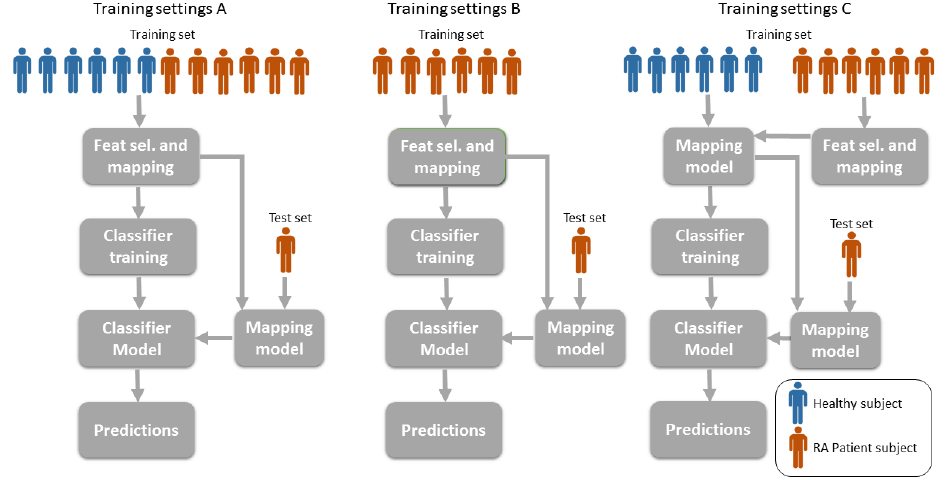
Figure 6. Training settings of the classifier. In setting A, data from healthy volunteers is appended to the patient dataset to increase its size. In setting B, only patient data is used to train the classifier model. Finally, in setting C, data from the patient population is used to find the most relevant features and build the mapping; then, the model is trained with healthy data only. In all cases, only patient data is employed to generate the predictions. As one would expect, the data used for tests will come from a different set than the one used for